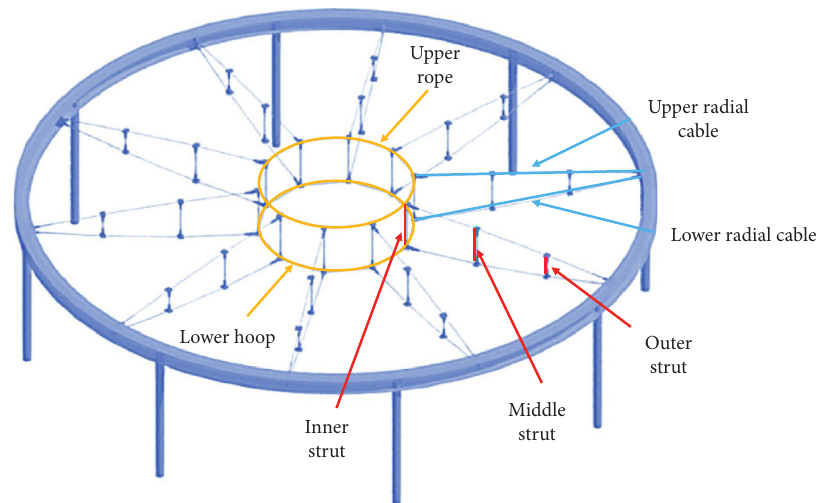
Figure 5: 3D model.